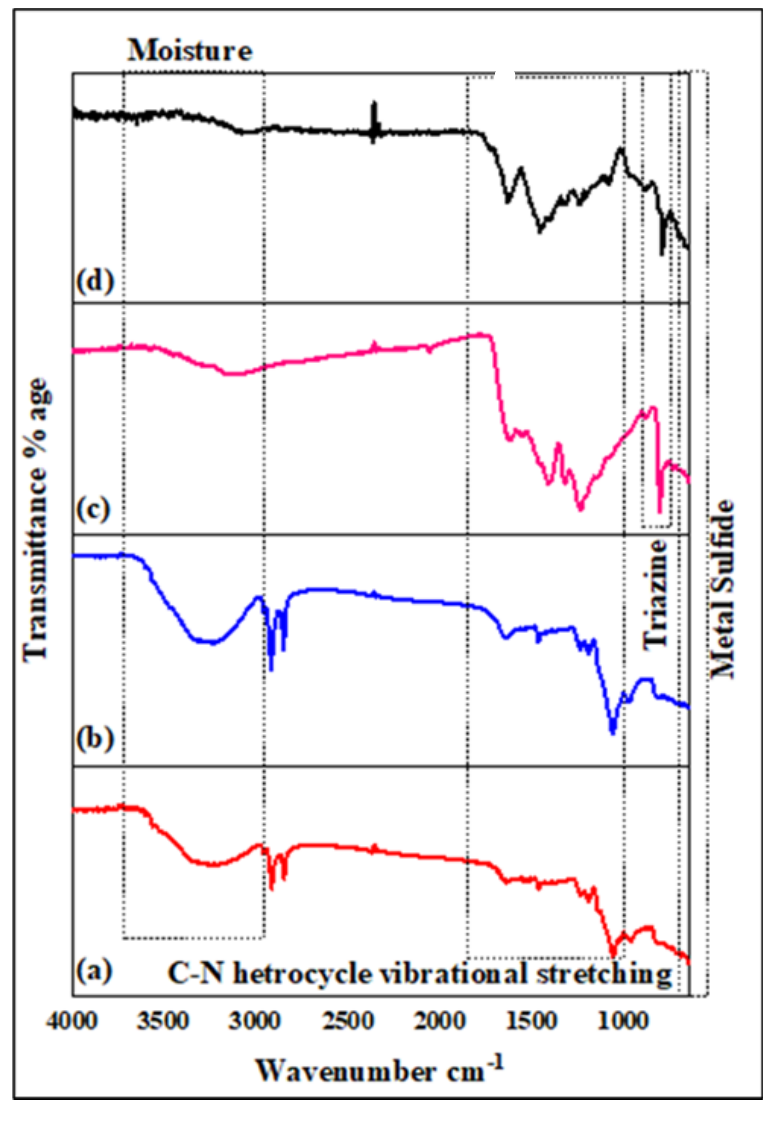
Figure 2. FTIR spectra of synthesized samples ( a ) NiS, ( b ) Te@NiS, ( c ) SGCN, and ( d ) SGCN/Te@NiS.